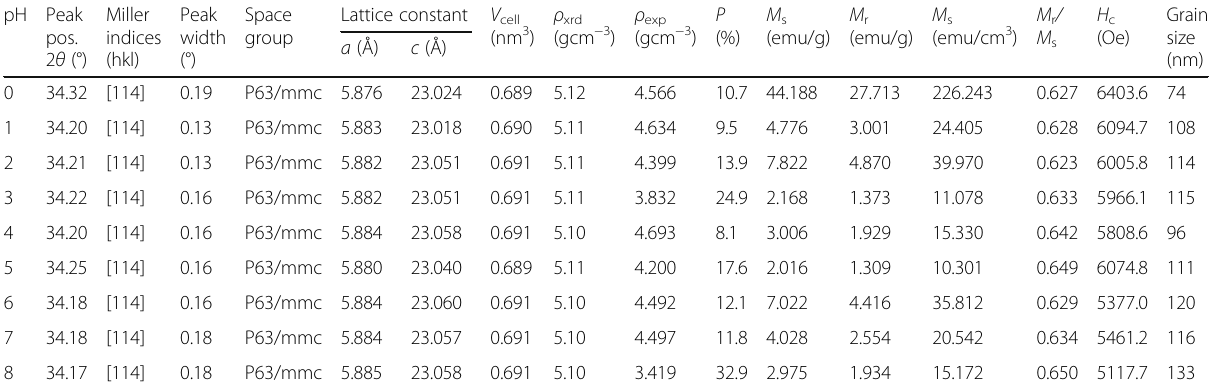
Table 1 The structural, microstructural, and magnetic parameters of the SrFe 12 O 19 sintered at 900 °C pH Peak pos.